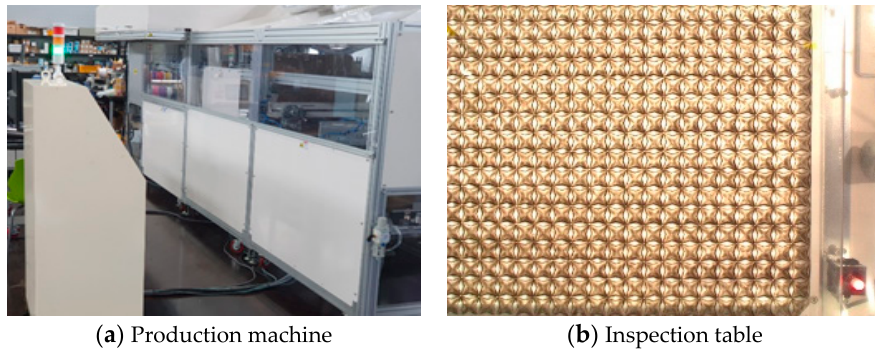
Figure 2. Three-dimensional film image production and inspection machine.